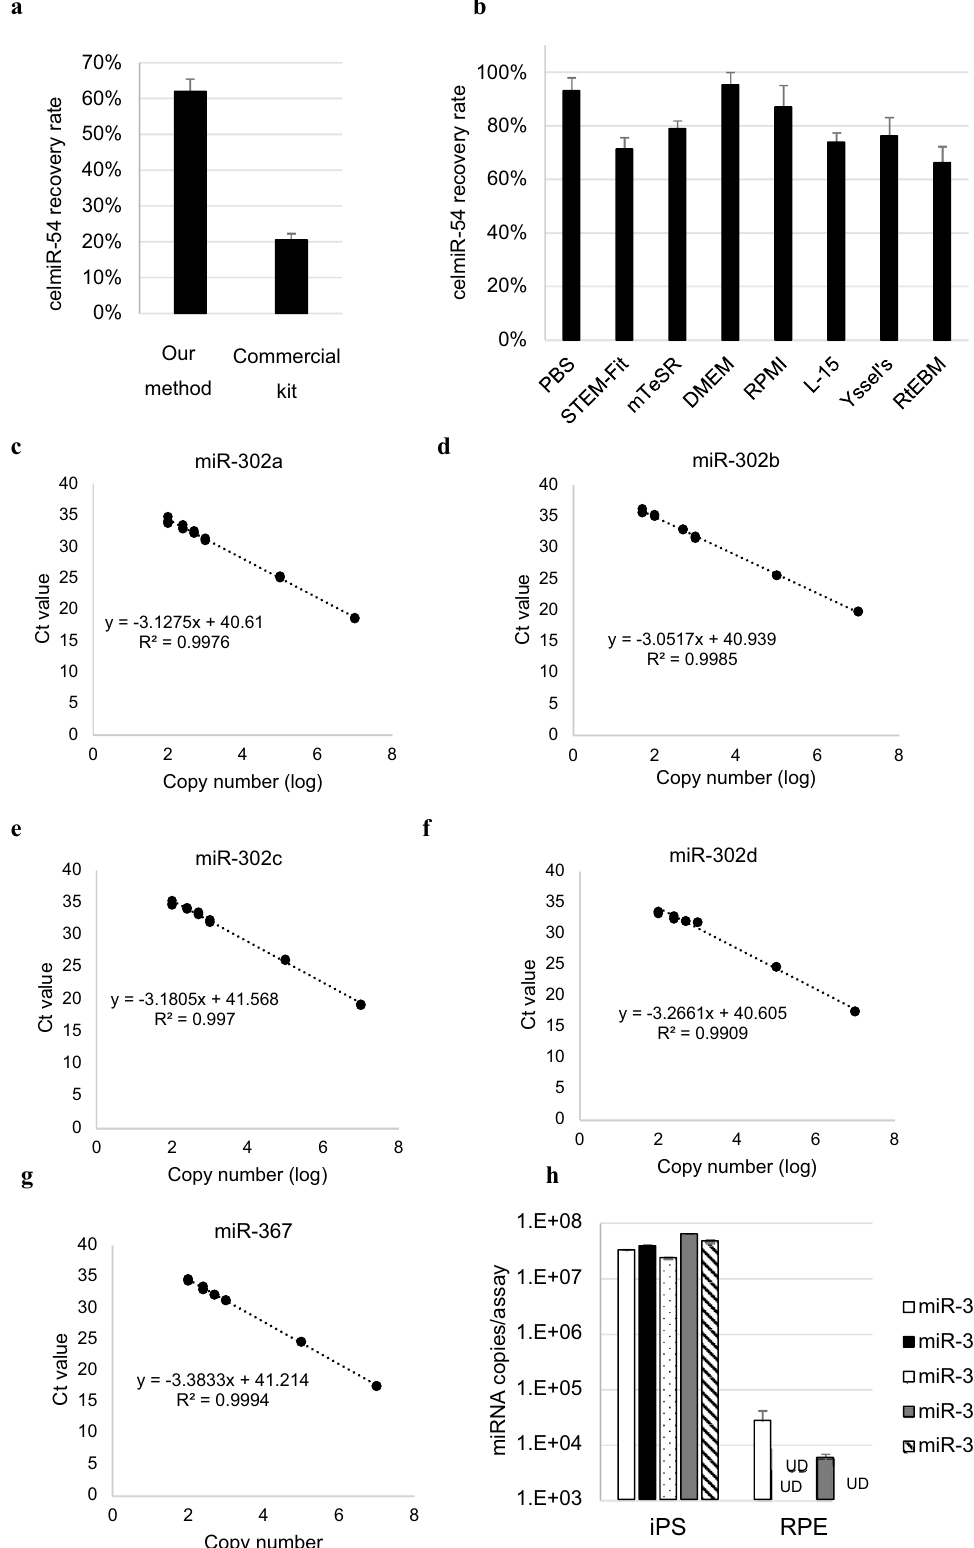
Figure 2. Highly efficient method to extract and detect miRNAs in culture supernatants was developed. ( a ) The recovery rate of spiked cel-miR-54 in PBS using our method and a commercially available kit, which is used to extract miRNAs using columns. ( b ) The recovery rate of spiked cel-miR-54 in various culture media using our method. ( c – g ) Calibration curves for each miRNA, plotted using the measured Ct values from 100 copies or 50 copies to 10 7 copies, and the theoretical copy number (log). The slope and R 2 value for each calibration curve are presented within the graph. ( h ) Level of each miRNA detected in the culture supernatant of iPSCs and RPE cells. UD: no miRNA detected; error bar = + 3SD